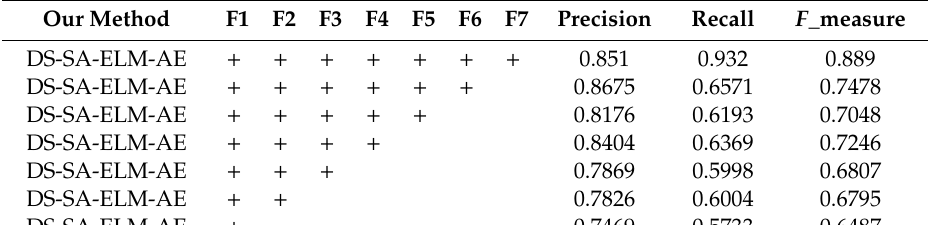
Table 4. The results obtained from the experiments carried out varying the list of features.